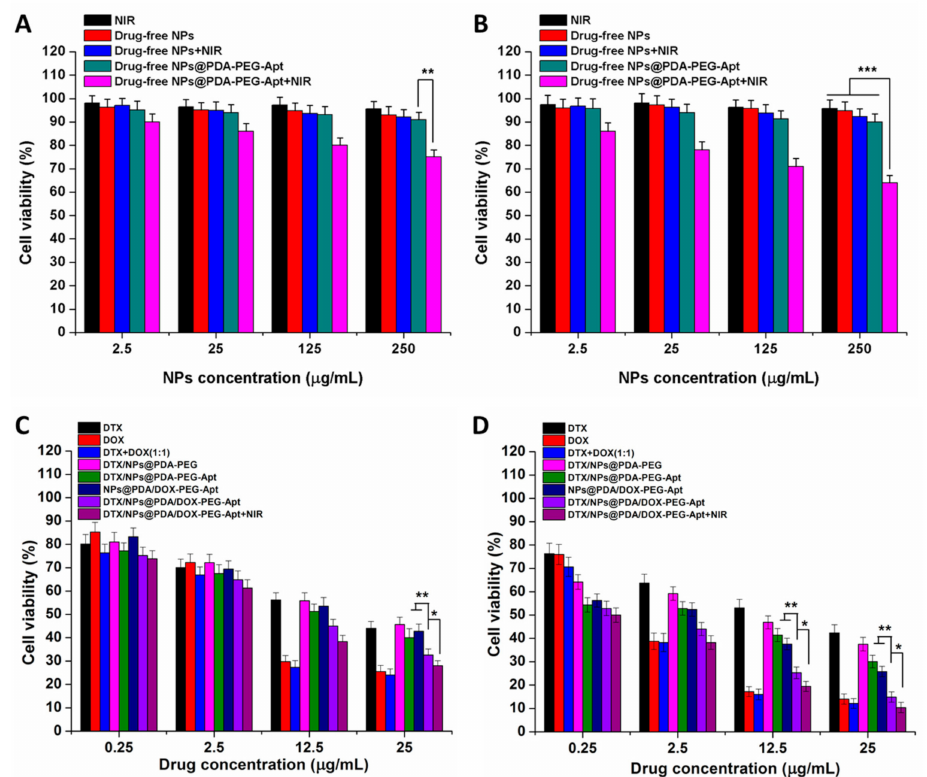
Figure 6. In vitro cytotoxicity on MCF-7 cells of NIR, drug-free NPs, drug-free NPs + NIR, drug-free NPs@PDA-PEG-Apt and drug-free NPs@PDA-PEG-Apt + NIR for ( A ) 24 h and ( B ) 48 h. Viability of